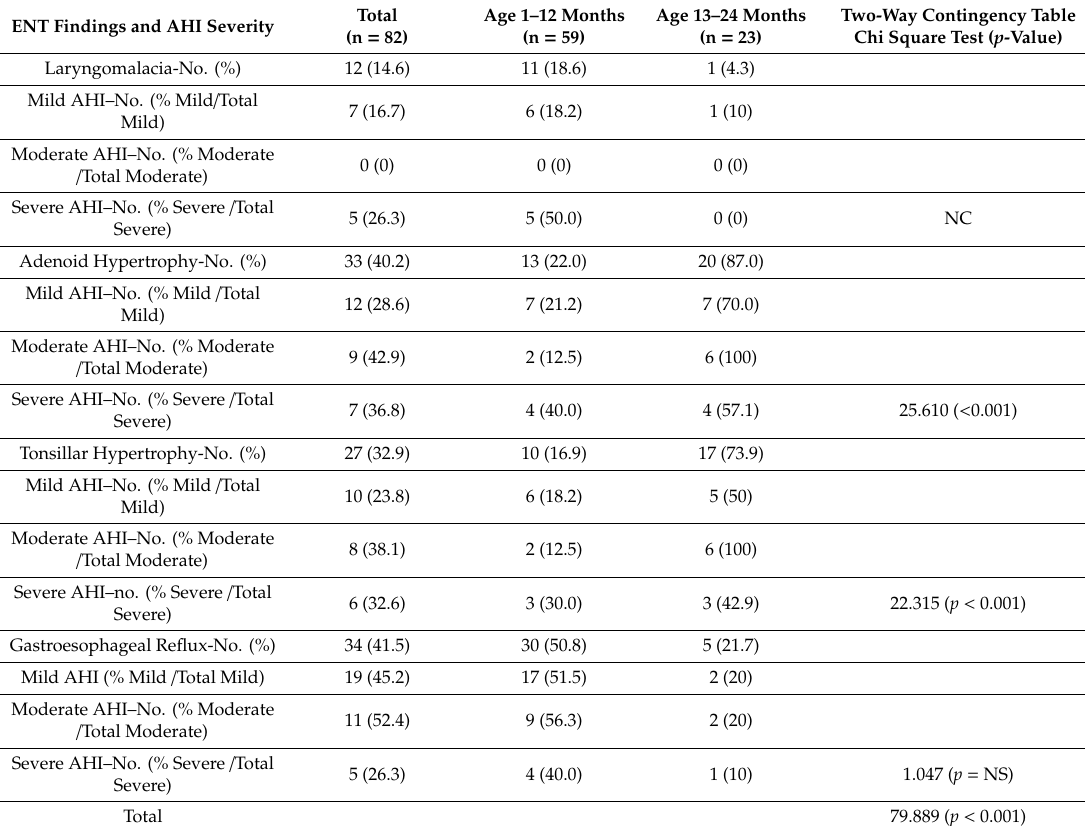
Table 4. Frequency (number and percentage) of laryngomalacia, adenoid, and tonsillar hypertrophy, and gastroesophageal reflux in the total sample (bold) and subgroups, and grade of apnea-hypopnea index severity (mild, moderate,